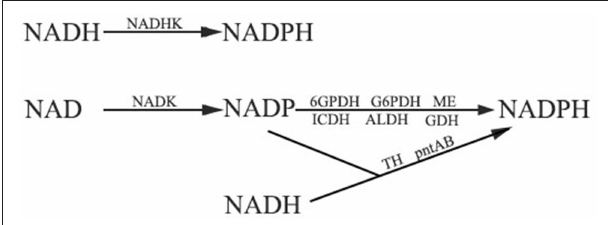
FIGURE 4 | The pathways of NADPH production. NAD(H) kinases play an important role in both the two NADPH generation pathways. Firstly, NADH kinase (NADHK) can catalyze NADH to synthesize NADPH directly. Secondly, NADPH can be generated by glucose-6-phosphate dehydrogenase (G6PDH), 6-phosphogluconate dehydrogenase (6GPDH), NADP-dependent isocitrate dehydrogenase (ICDH), NADP-dependent malic enzymes (ME), NADP-dependent aldehyde dehydrogenase (ALDH), and NADP-dependent glutamate dehydrogenase (GDH). Transhydrogenase (TH) and proton-trans-locating transhydrogenase (pntAB) can also generate NADPH. NAD kinase functions in providing NADP to these enzymes.